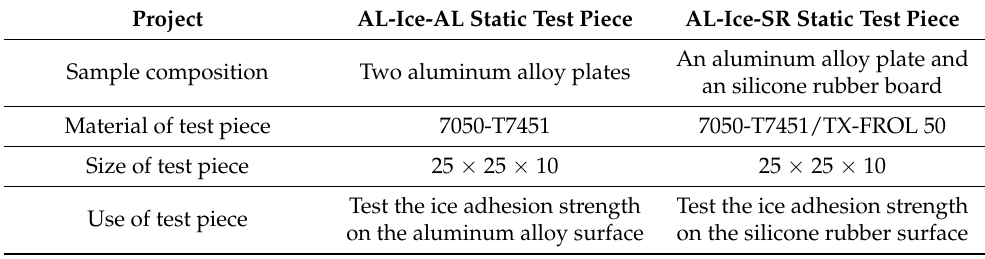
Table 2. Test piece information sheet.